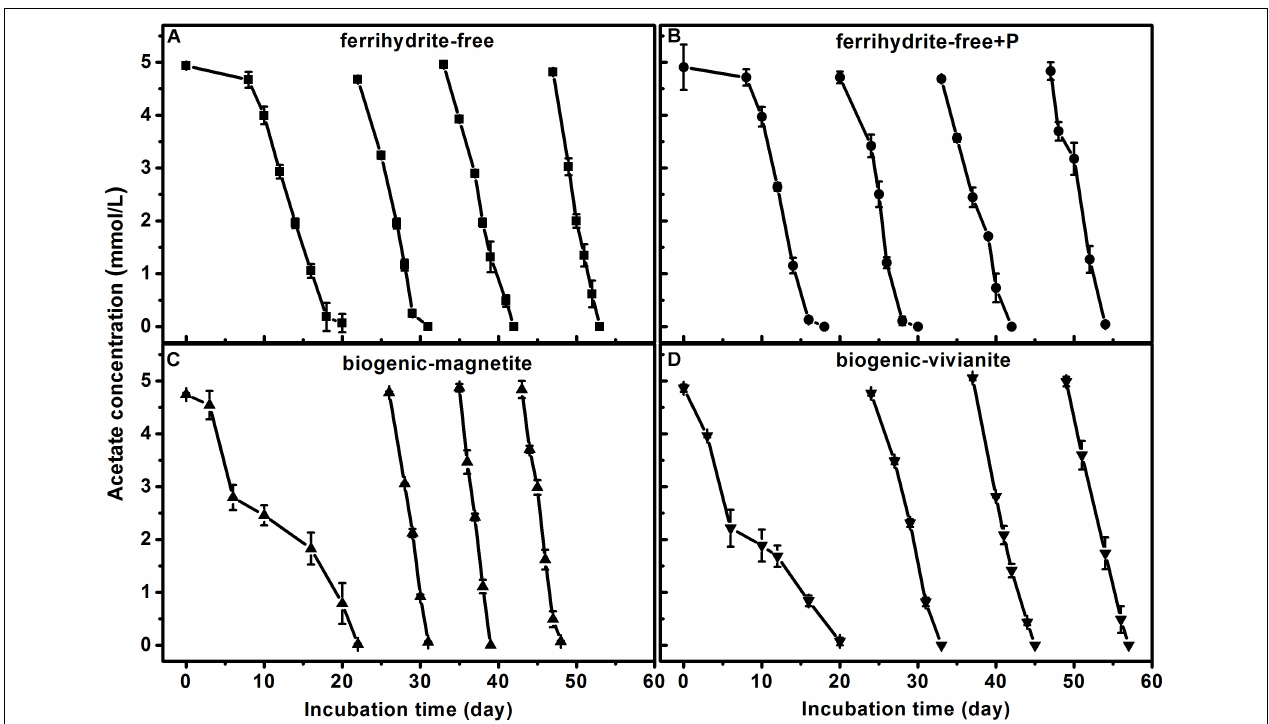
FIGURE 2 | Acetate degradation in different treatments: (A) ferrihydrite-free cultures, (B) ferrihydrite-free + P cultures, (C) biogenic-magnetite cultures, and (D) biogenic-vivianite cultures (the arrows denote the addition of